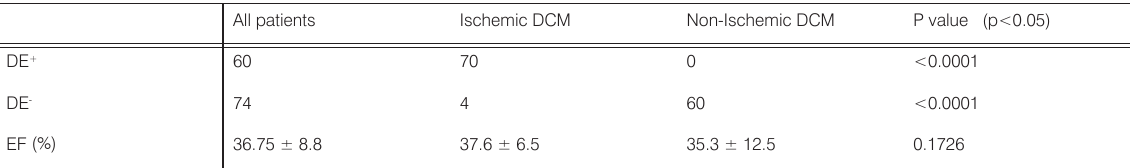
Table 5. Evaluation of the use of Delay Enhancement with cardiac magnetic resonance (CMR) imaging to measure the ejection fraction versus use of 2-D echocardiography in enrolled patients. Delay Enhancement (DE), Ejection fraction (EF), DCM: Dilated Cardomyopathy. All patients